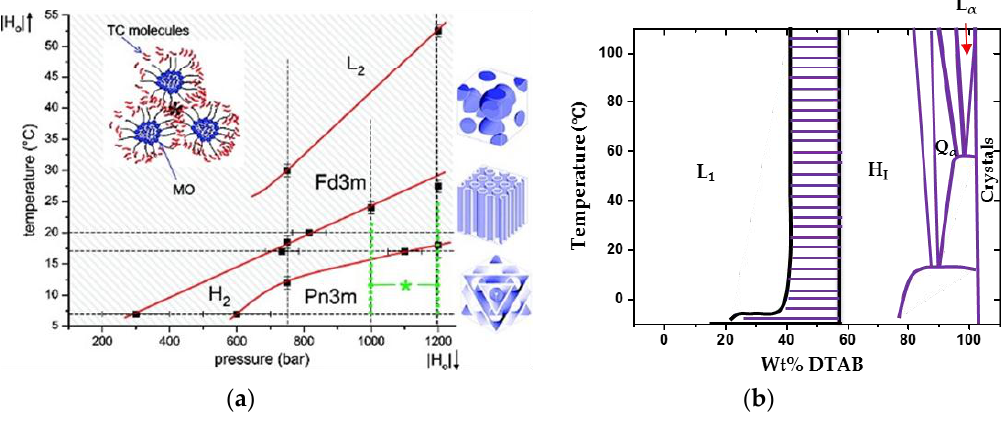
Figure 6. ( a ): Temperature-pressure behaviour of fully hydrated tetradecane-loaded monoolein/water system; ( b ): Temperature-concentration dependent behaviour of LLCs formed of DTAB and water [34,35] (Adapted with permissions from [34,35]. Copyright (2009 and 1995) American Chemical Society).